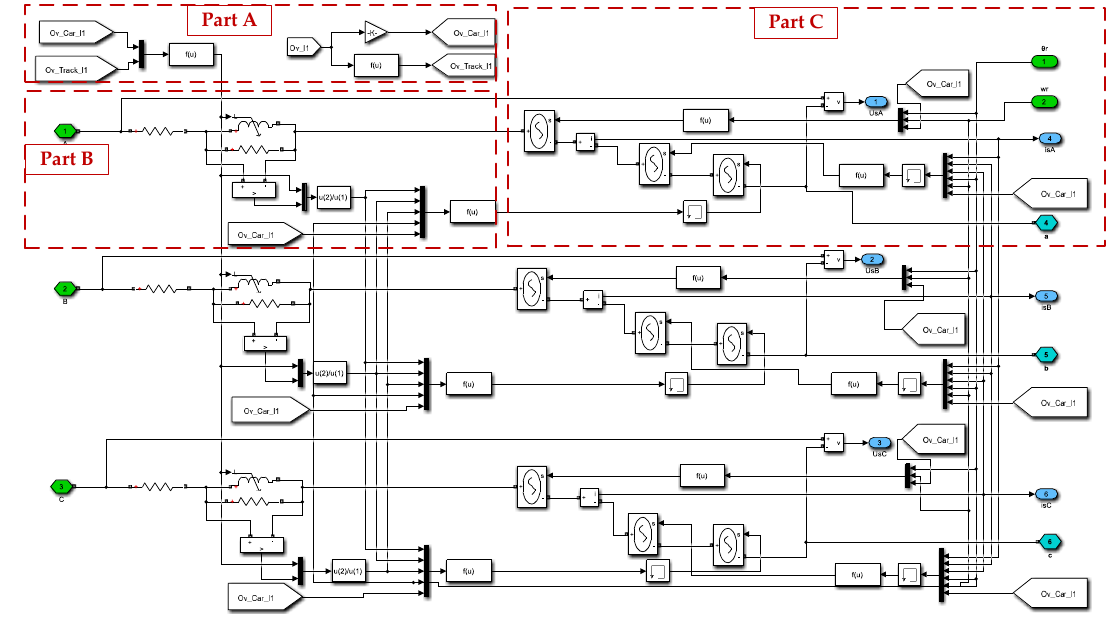
Figure 5. Motor internal modeling method.